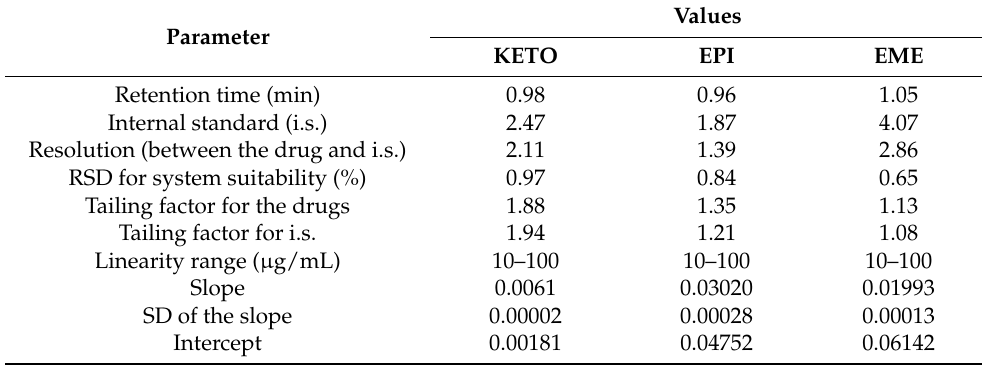
Figure 2. Representative chromatograms of KETO (t R = 0.984 min), EPI (t R = 0.962 min) and EME (t R = 1.052 min) in their ocular drops ( A ) and in the samples stressed in 0.1 M NaOH ( B ) (in the presence of internal standards). Table 1. Validation of HPLC methods for determination of ketotifen (KETO), epinastine (EPI) and emedastine (EME) ( n =